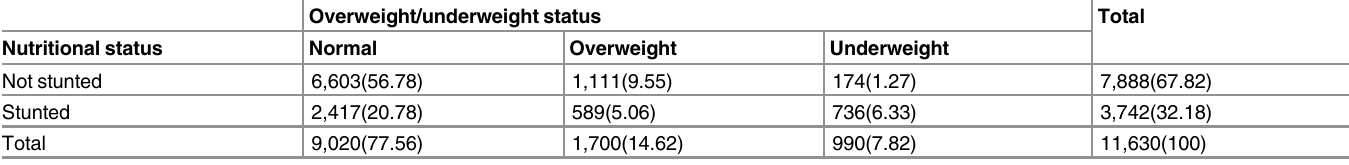
Table 1. Sample sizes and percentages of stunting across overweight/underweight status among children in rural China, the CHNS 1991 – 2009.